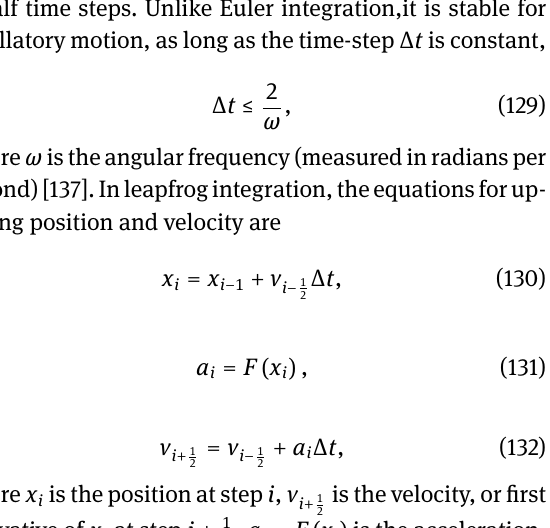
disk with radius one centred at (+1, 0) (Fig. 39). This in- cludes the whole left half of the complex plane, so the backward Euler method is A-stable, making it suitable for the solution of stiff